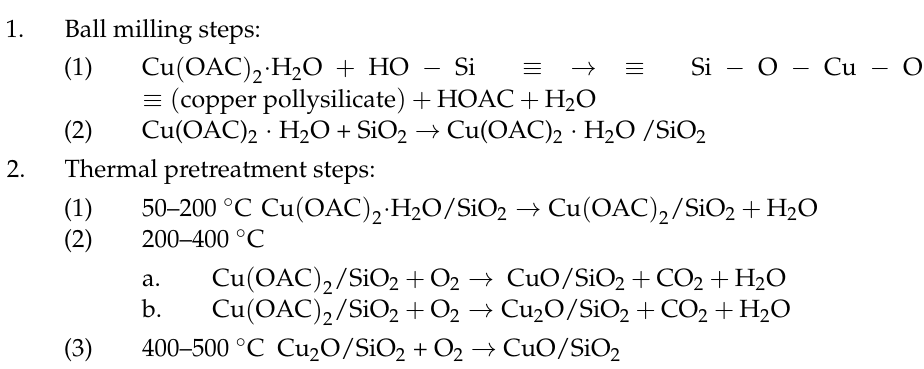
Figure 10. Effect of copper loading over the W% Cu-A-BM catalysts on the copper active surfaces and the T 90 .